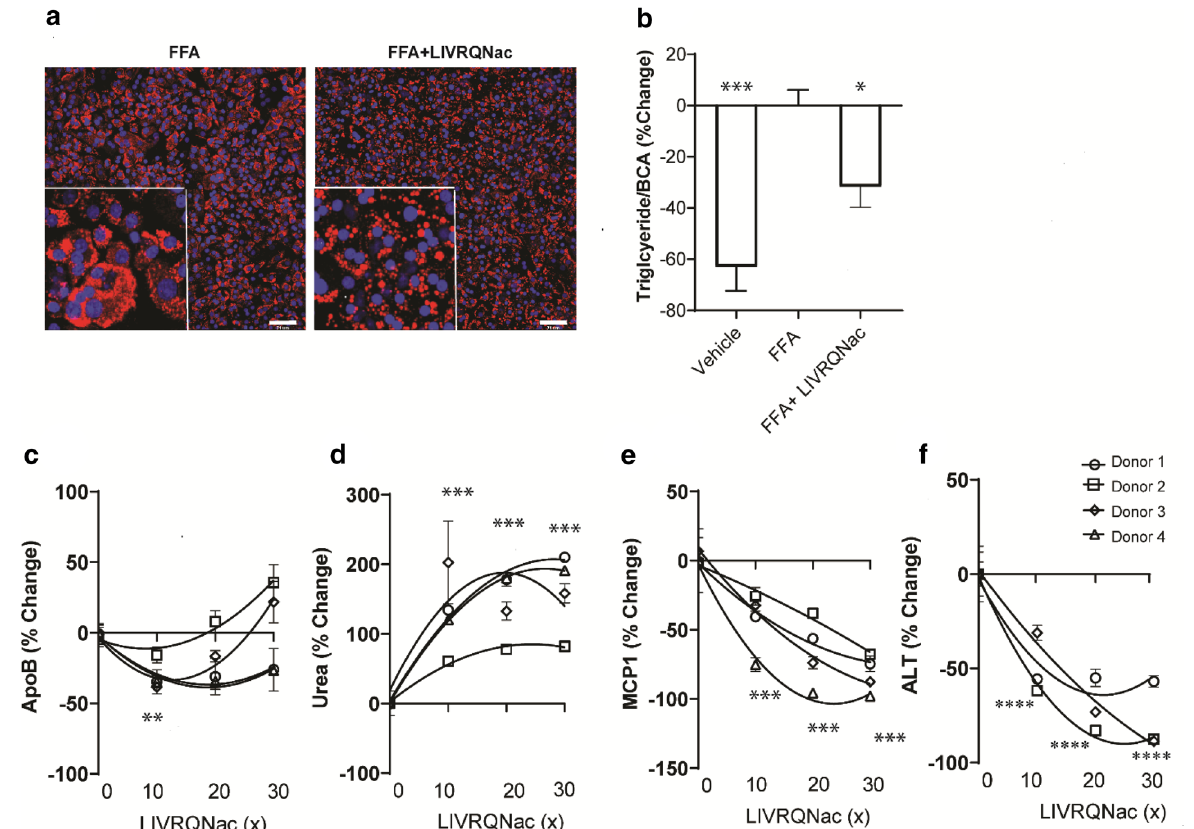
Figure 1. LIVRQNac improves dysregulated metabolism in a NASH-relevant primary human hepatocyte model of lipotoxicity. ( a ) Representative images of PHHs exposed to lipotoxic insult (FFA group) for 72 h in the presence (right) or absence (left) of LIVRQNac (30x relative to human plasma concentration for LIVRQ and 7.5 mM Nac; applied 24 h before lipotoxic insult) and stained with high-content screening LipidTOX red neutral lipid stain (red) to reveal lipid droplets and with Hoechst (blue) to show nuclei. Scale bars 74 µm. Insets have been magnified to provide greater clarity of the lipid phenotype. ( b ) Intracellular triglyceride levels measured in PHHs treated with vehicle (without lipotoxic insult) or exposed to lipotoxic insult (FFA group) and treated with LIVRQNac (30x relative to human plasma concentration for LIVRQ and 7.5 mM Nac, applied 24 h before lipotoxic insult) for 72 h post insult. Data are normalized to protein concentration assessed by BCA assay and shown as a mean percentage change relative to the FFA group. Data represent at least two technical replicates from at least three independent donors. Error bars represent ± SEM. * p < 0.05 versus FFA group, *** p < 0.001 versus FFA group. ( c ) ApoB, ( d ) urea, ( e ) MCP-1, ( f ) ALT levels measured in PHH supernatant exposed to lipotoxic insult (FFA group) and treated with either phosphate-buffered saline (0x) or LIVRQNac (10x–30x relative to human plasma concentration for LIVRQ and 2.5–7.5 mM Nac; applied 24 h before lipotoxic insult) for 72 h (ApoB and Urea, ALT) or 24 h (MCP-1) post insult. 0x corresponds to FFA-stimulated PHHs without additional LIVRQNac. Data are displayed as percent change relative to vehicle-treated PHHs exposed to lipotoxic insult (0x) and represent the mean of three technical replicates from four individual donors. Error bars represent ± SEM. ** p < 0.01, *** p < 0.001, **** p < 0.0001 versus FFA (0x) group for all four donors combined. Analysis was performed using GraphPad Prism version 9.0.1 for Windows, GraphPad Software, San Diego, California USA, www. graph pad. com. The graphs were assembled using Adobe Illustrator CC 2019, www.